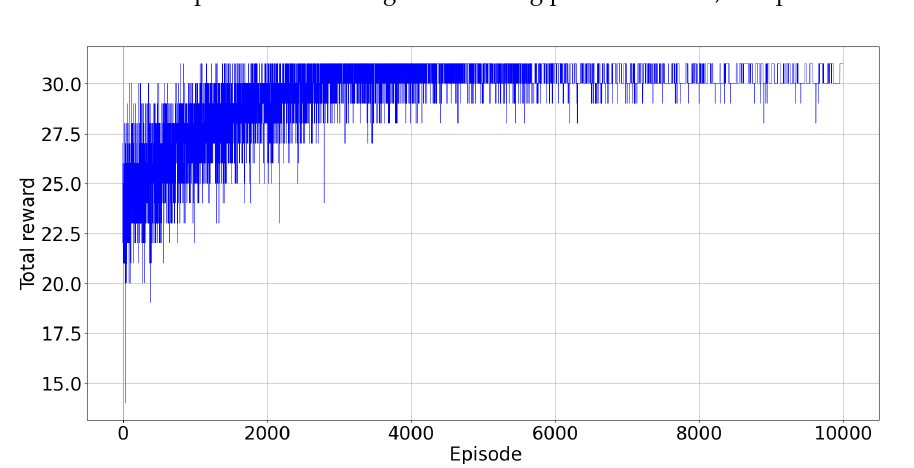
Figure 4. Scenario 1: Total observed reward at each training episode.